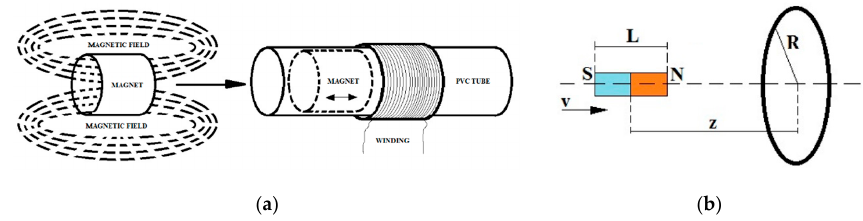
Figure 4. Transducer principle operation and description: ( a ) N-turns coil with a moving magnet inside and ( b ) equivalent scheme of the magnet-coil with a single-turn coil carrying N-times the real coil current.